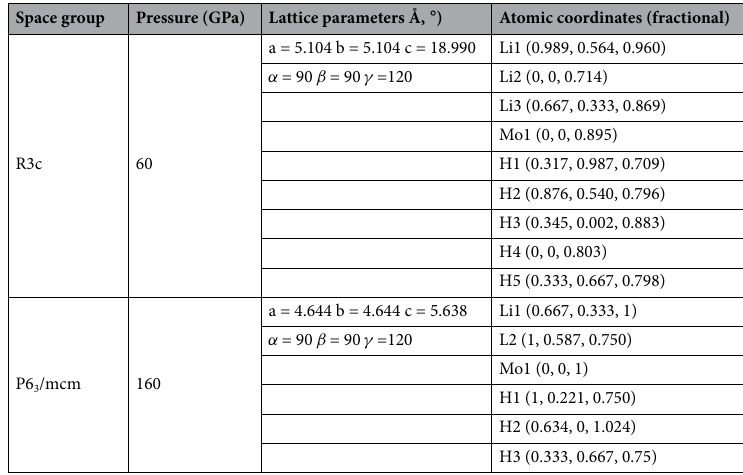
Table 1. Structures of Li 5 MoH 11 .